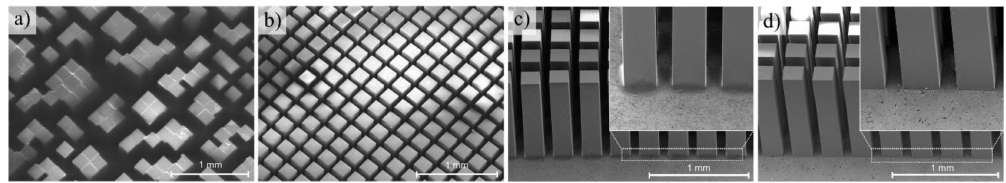
Figure 2. Optimization process during the evaporation process. After the evaporation process using ( a ) pure DI water; ( b ) DI water + surface additive. E ff ect of evaporation direction ( c ) upward direction; ( d ) downward direction.